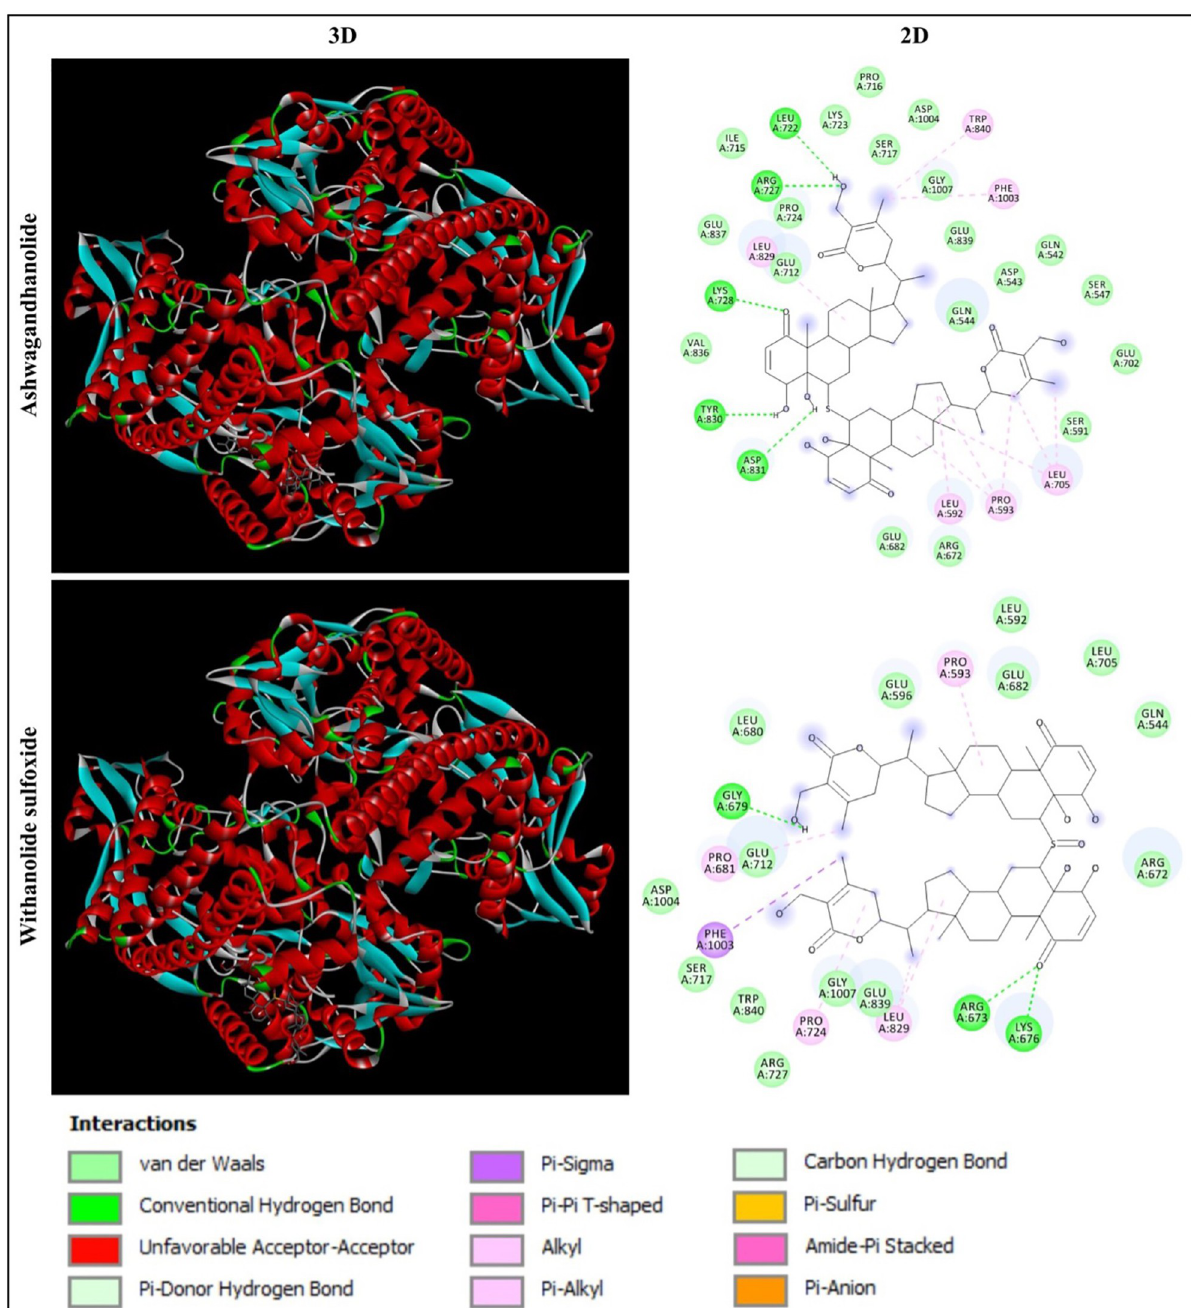
Fig 6. Interaction of human TOP2A (PDB: 5GWK) with Ashwagandhanolide and Withanolide sulfoxide. Three-dimensional (3D) illustration shows the interaction of ligands with human TOP2A structure and two-dimensional (2D) diagram displays the interactions of the ligand with the specific amino acid residues in the active site of the